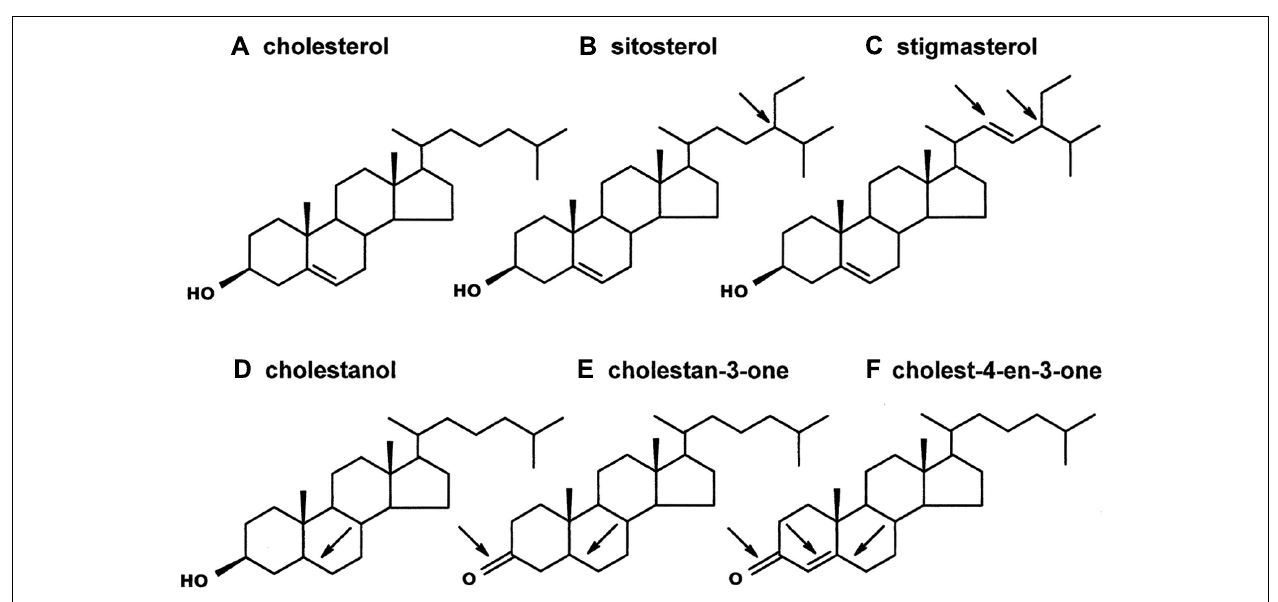
three steroids in the bottom row have been identified in a transgenic tobacco line on which aphids perform poorly (Behmer etal., 2011). Cholestanol (D) is similar to cholesterol but it lacks a double bond at the C5-position. Cholestan -3-one (E) and Cholest-4-en-3-one (F) both have a ketone at the C3-position, and both lack a double bond at the C5-position; cholest-4-en-3-one, in contrast to cholestan-3-one, has a double bond at the